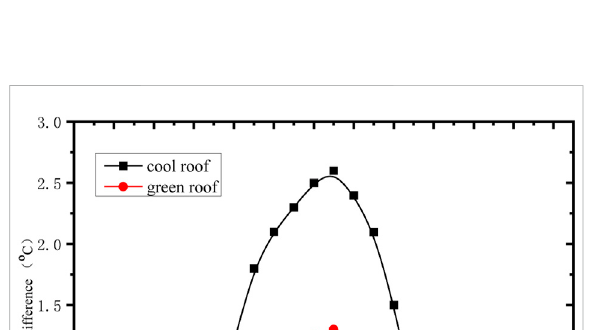
FIGURE 15 Ambient air temperature with different roofs in hot summer and warm winter zones.